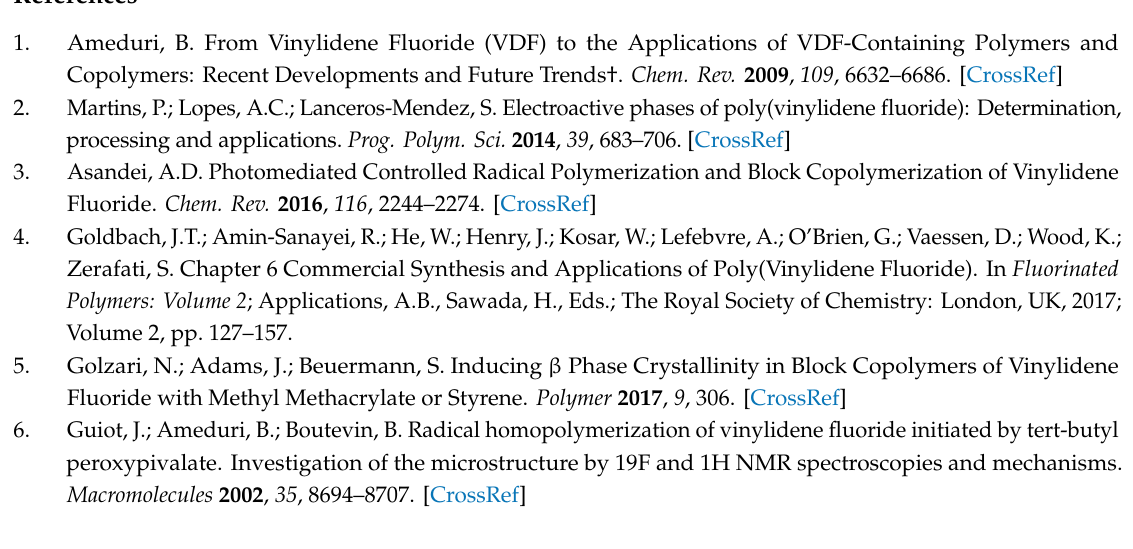
Figure S1: First-order kinetics plot for the polymerization of VDF initiated by visible light in presence of [Mn(CF 3 )(CO) 5 ]. Figure S2: First-order kinetics plot for the polymerization of VDF initiated by UV irradiation (300 nm) in the presence of [Mn(CF 3 )(CO) 5 ]. Figure S3: SEC traces of PVDF samples obtained by thermal radical polymerization of VDF with [Mn(CF 3 )(CO) 5 ] in DMF normalized with conversion (entries 2, 3, 4, and 7 of Table 1). Figure S4: SEC traces of PVDF samples initiated by visible light (entries 9 to 11 of Table 1) in DMF normalized with conversion. Figure S5: SEC traces of PVDF samples initiated by UV irradiation (entries 12 to 14 of Table 1) in DMF normalized with conversion. Figure S6: SEC traces of PVDF samples (entries 7, 11, and 14 of Table 1) in DMF after 24 h-reaction by various initiation methods. Figure S7: Plot of the number of average molar mass and dispersity vs. conversion of VDF polymerization initiated thermally (100 ◦ C) by complex 1. Figure S8: Plot of the number of average molar mass and dispersity vs. conversion of VDF polymerization initiated by complex 1 under visible light irradiation. Figure S9: 1 H NMR spectrum (400 MHz, DMF- d 7 ) of the PVDF obtained by thermal activation of 1 (entry 7 of Table 1). Figure S10: 19 F NMR spectrum (376.5 MHz, DMF- d 7 ) of the PVDF obtained by thermal activation of 1 (entry 5 in Table 1). Figure S11: 1 H NMR spectrum (400 MHz, DMSO- d 6 ) of the PVDF obtained by visible light activation of 1 (entry 11 of Table 1). Figure S12: 19 F NMR spectrum (376.5 MHz, DMSO- d 6 ) of the PVDF obtained by visible light activation of 1 (entry 11 of Table 1). Figure S13: 1 H NMR spectrum (400 MHz, DMF- d 7 ) of the PVDF obtained by UV light activation of 1 (entry 14 of Table 1). Figure S14: 19 F NMR spectrum (376.5 MHz, DMF- d 7 ) of the PVDF obtained by UV light activation of 1 (entry 14 of Table 1). Figure S15: 19 F NMR spectrum (376.5 MHz, DMF- d 7 ) of the PVDF obtained by visible activation of 2 (entry 2 of Table 4). Figure S16: 19 F NMR spectrum (376.5 MHz, DMF- d 7 ) of the PVDF obtained by UV activation of 2 (entry 3 of Table 4). Figure S17: 1 H NMR spectrum (400 MHz, acetone- d 6 ) of the PVDF obtained by thermal activation of 3 (entry 6 of Table 4). Figure S18: 19 F NMR spectrum (376.5 MHz, acetone- d 6 ) of the PVDF obtained by thermal activation of 3 (entry 6 of Table 4). Figure S19: 19 F NMR spectrum (376.5 MHz, DMSO- d 6 ) of the PVDF obtained by thermal activation of 5 (entry 7 of Table 4). Figure S20: 1 H NMR spectrum (400 MHz, acetone- d 6 ) of the poly(VAc- alt -MAF-TBE) obtained by thermal activation of 3 (entry 4 of Table 5). The starred resonance is due to the solvent. Figure S21: 19 F NMR spectrum (376.5 MHz, acetone- d 6 ) of the poly(VAc- alt -MAF-TBE) obtained by thermal activation of 3 (entry 4 of Table